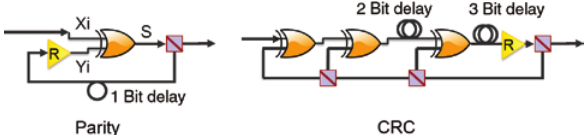
Figure 12: Parity and CRC via simple serial feedback circuits.